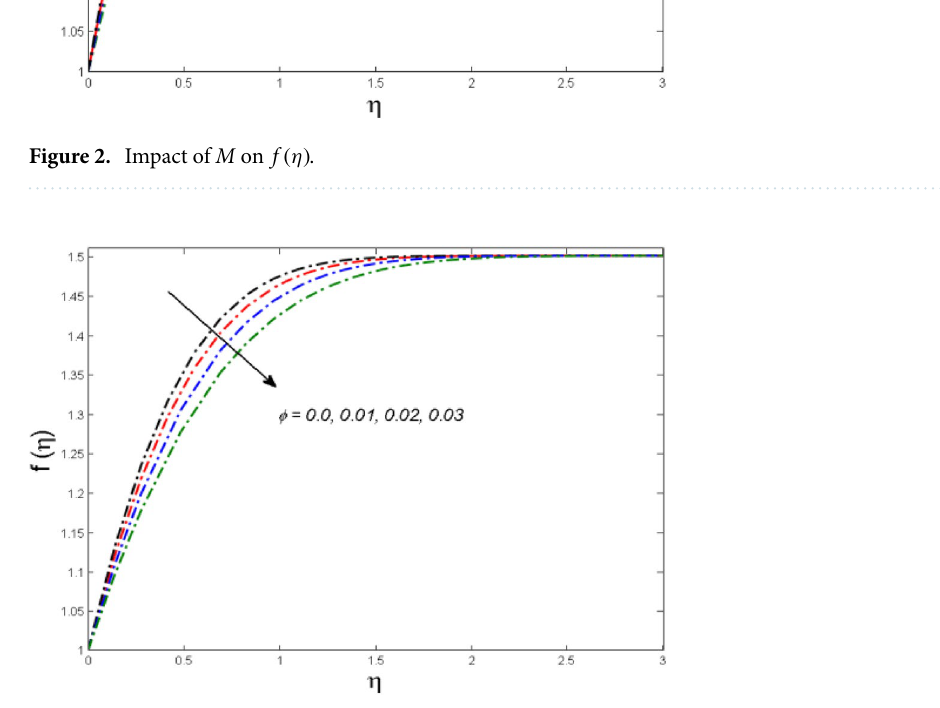
Figure 3. Impact of φ on f (η)